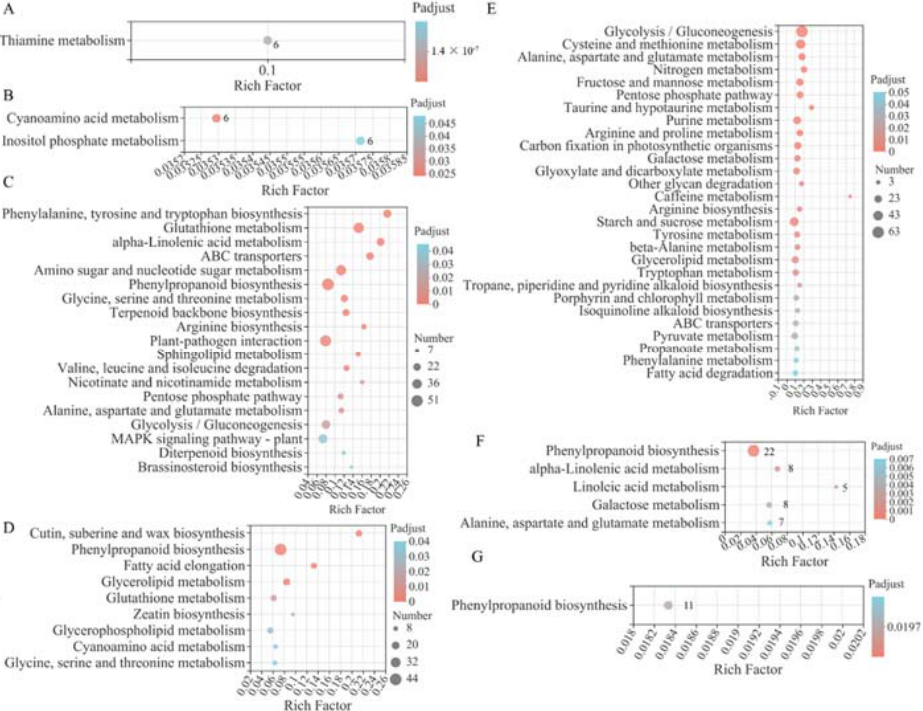
Figure 6. KEGG enrichment analyses of DEGs involved in MEcyan ( A ), MEpurple ( B ), MEblue ( C ), MEgreen ( D ), MEturquoise ( E ), MEpink ( F ), and MEsalmon ( G ). The numbers beside the bubbles in ( A , B , F , G ) represent the numbers of genes.